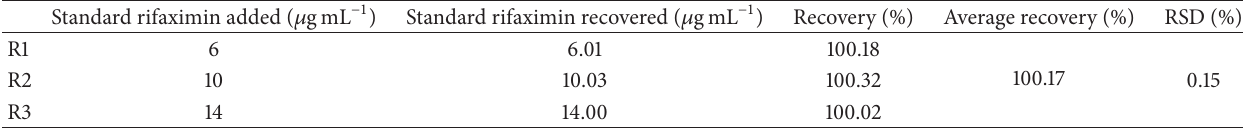
Table 4: Values of recovery test of the absorption spectrophotometric method in the ultraviolet region.